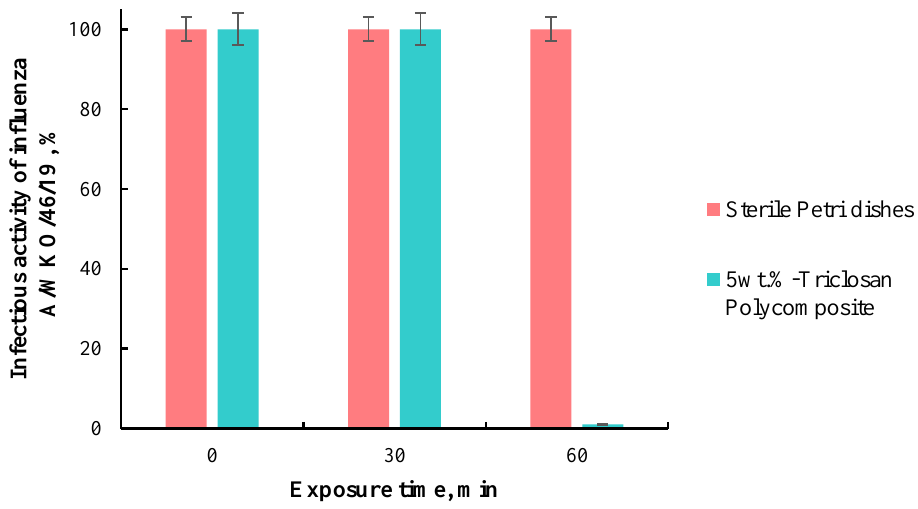
Figure 5. The infectious activity of influenza A/WKO/46/19 virus after 60 min of incubation on sterile Petri dishes and polymer composite.